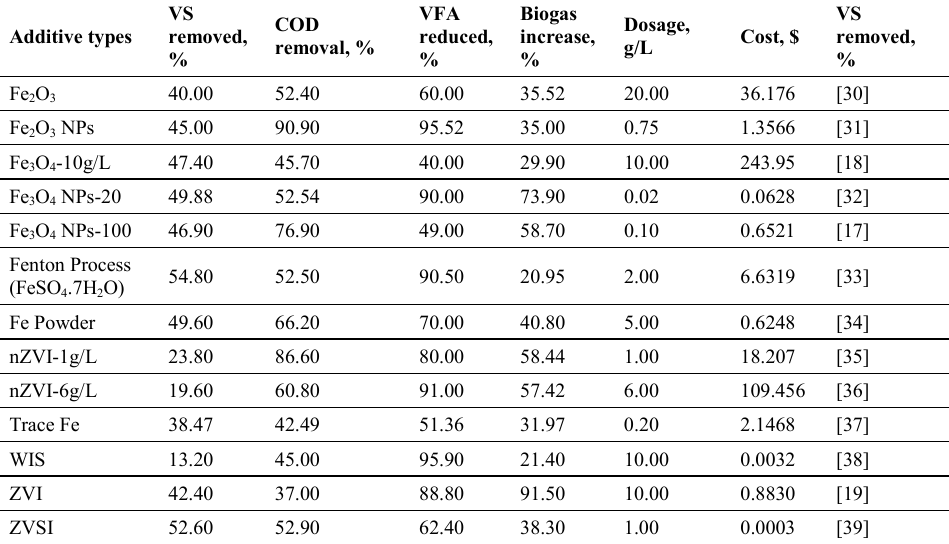
Table 1. The selection of alternatives was restricted to literature information on efficiency, availability and frequency of use for anaerobic digestion of sludge. The additive costs used were average prices from reputable online stores. The six attributes were selected because their performances influence the choice of iron-based